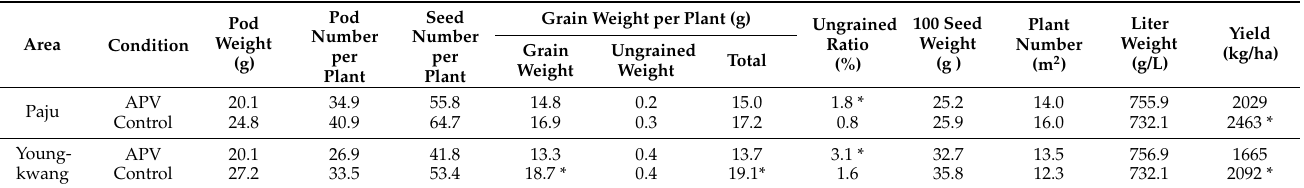
Figure 3. Growth of soybean underneath agrophotovoltaic (APV) systems in Paju ( A ) and Youngkwang ( B ), South Korea. * significantly different between APV system and control plot at different investigation dates using a t -test ( p = 0.05). Table 6. Growth and yield of soybean underneath agrophotovoltaic (APV) systems in Paju and Youngkwang, South